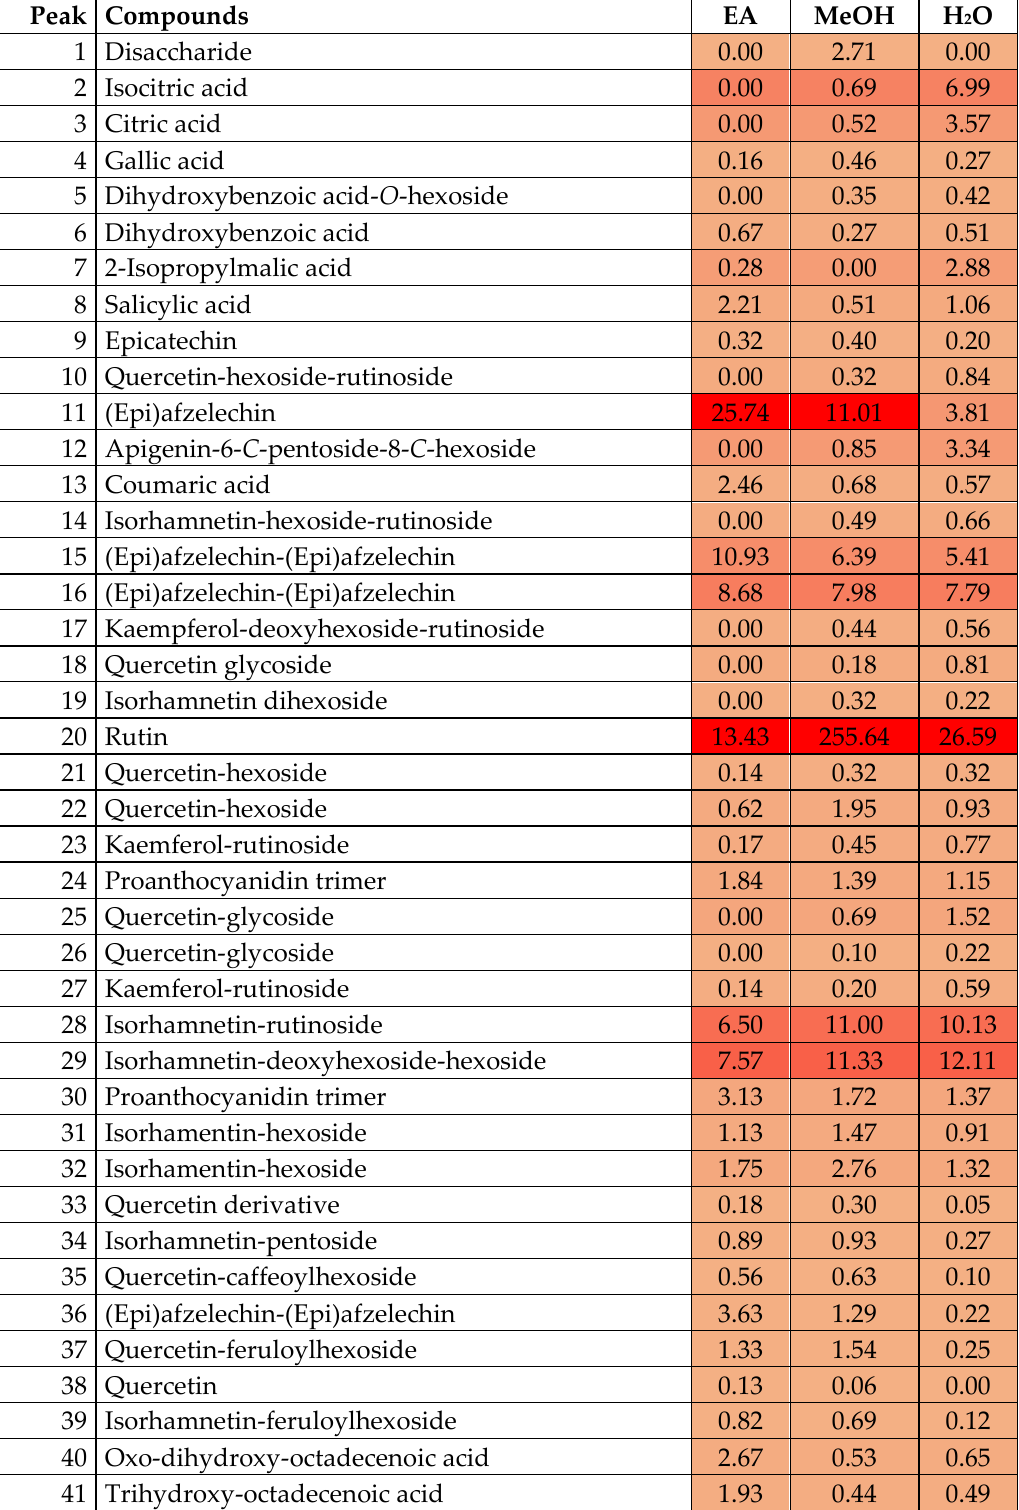
Figure 1. Relative peak areas and heat map obtained by HPLC-Q-TOF-MS-MS analysis of extracts of R. madagascariensis . Hex and dHex stand for hexoside and deoxyhexoside, respectively.